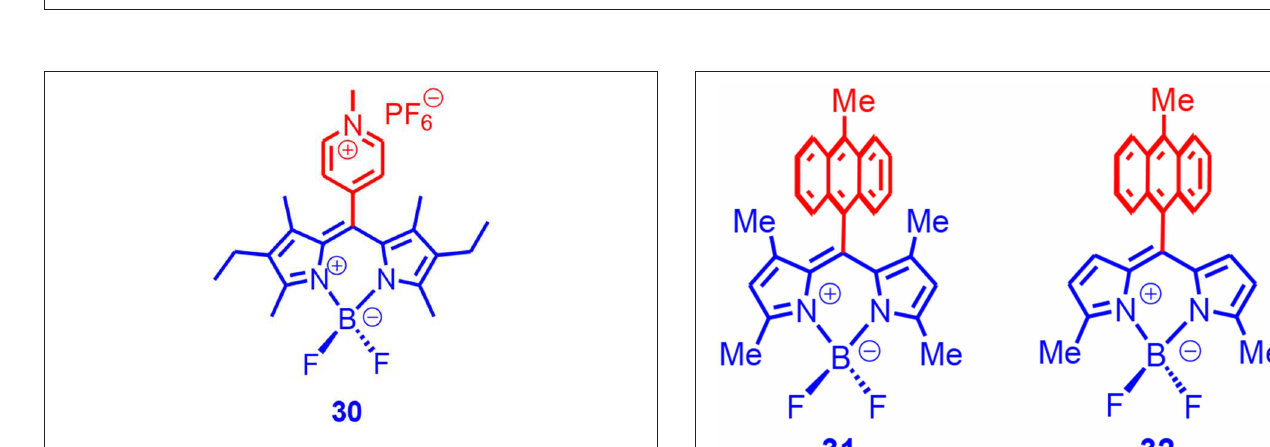
FIGURE 9 | Bodipy derivative with pyridium electron acceptor unit.